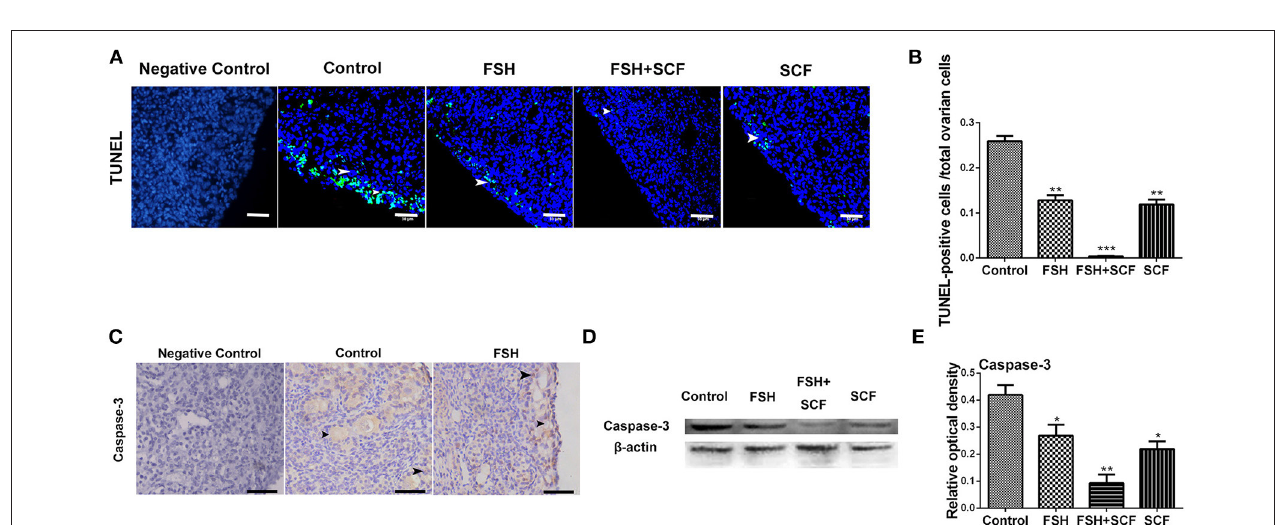
FIGURE 11 | Combined effects of FSH and SCF on cell apoptosis. (A) Ovarian cells (arrowheads) with TUNEL (green) marker indicate cell apoptosis after the treatment of 4-day-old chicken ovaries with FSH or SCF in vitro for 3 days. DAPI (blue) represents nuclear DNA. Scale bar: 30 µ m. (B) The percentage of TUNEL positive cells reduced significantly after FSH and SCF treatment. (C) Caspase-3 protein is indicated by a brown stain. Arrowheads represent the ovarian cells stained caspased-3 marker. (D,E) Western blot and gray analysis indicate that FSH inhibited caspase-3 protein expression. SCF acted to enhance the effect of FSH in inhibiting caspase-3 expression in vitro . T -tests were used to determine statistically significant differences. The values are the mean ± SEM of six experiments. Asterisks indicate significant differences (* P < 0.05, ** P < 0.01, *** P < 0.001).